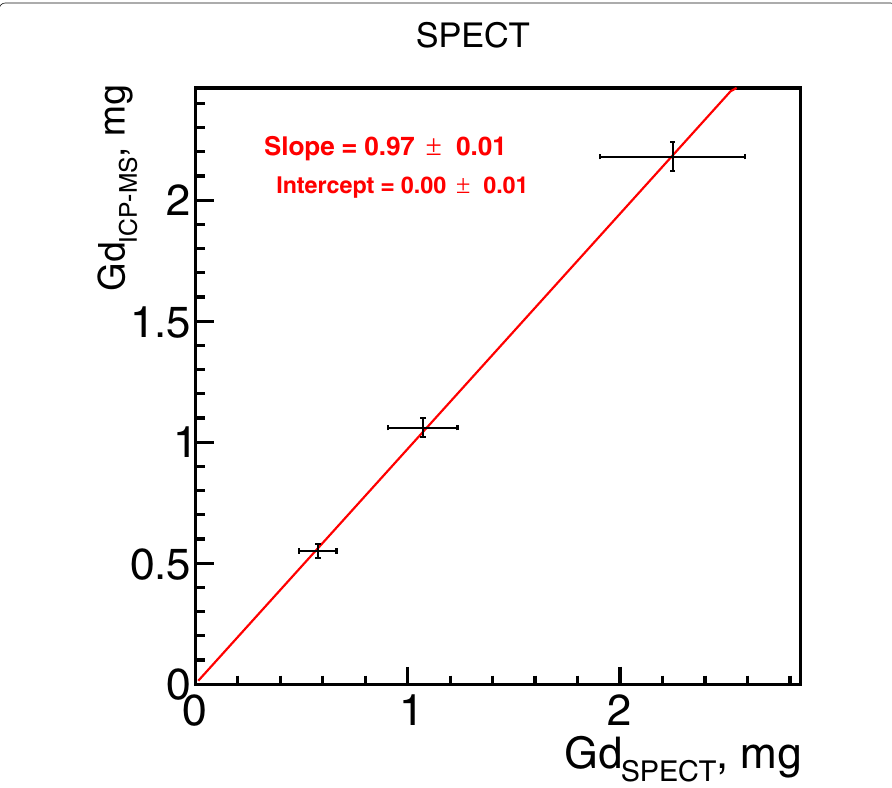
Fig. 4 Gadolinium mass from SPECT images in phantom studies. Gadolinium mass measurement from SPECT images for 111 In + Gd phantom samples as a function of expected mass of gadolinium measured with ICP-MS